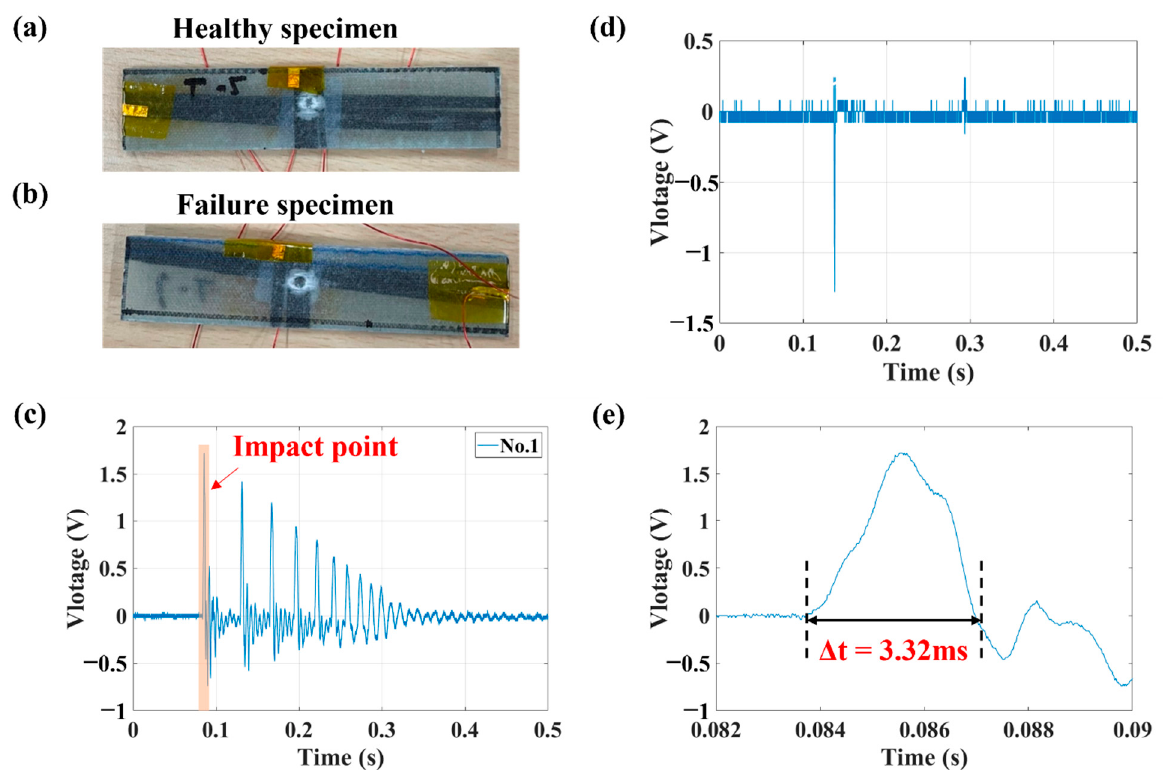
Figure 10. Photographs of a ( a ) healthy specimen and ( b ) failed specimen; piezoelectric response of a ( c ) healthy specimen and ( d ) failed specimen; ( e ) piezoelectric response ( a ) impact point.